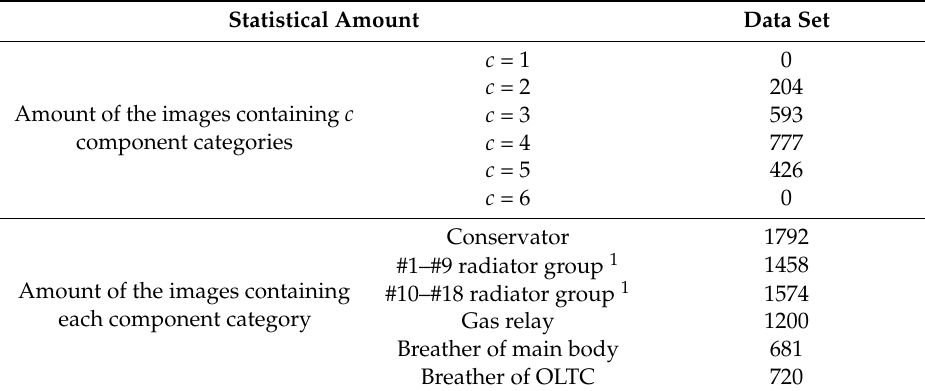
Table 2. Statistics of images with different component category cases in the data set.